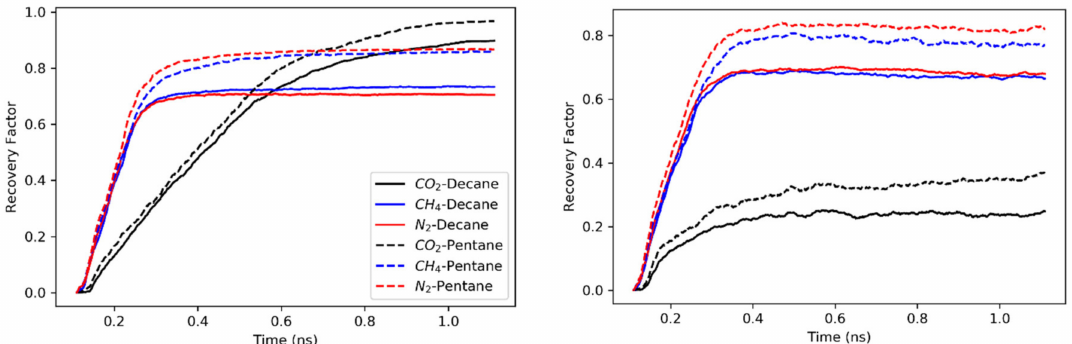
Figure 5. Recovery Factor for multi-component systems with constant-rate injection ( Left ) and without ( Right